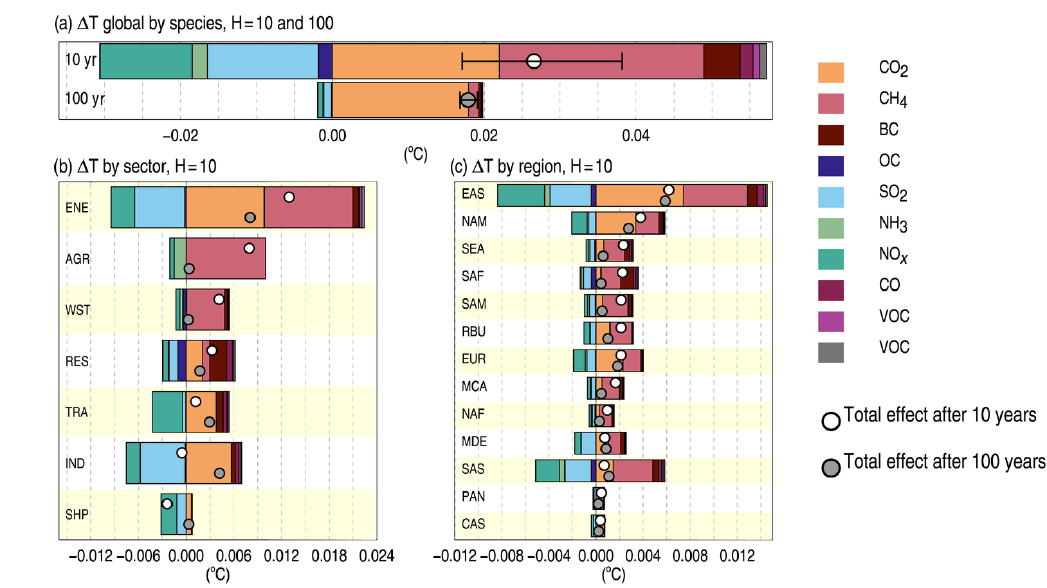
Figure 2. Global-mean surface temperature impact ( ◦ C) (a) 10 and 100 years after 1 year of present-day (i.e., year 2014) global total emissions of SLCFs and CO 2 , (b) after 10 years following emissions from 7 major economic sectors, and (c) after 10 years following emissions in 13 source regions. Panels (b) and (c) are sorted by total net effect on the 10-year timescale (white circle). Error bars ( ± 1 SD) in (a) represent the range in total net temperature impact due to uncertainties in radiative